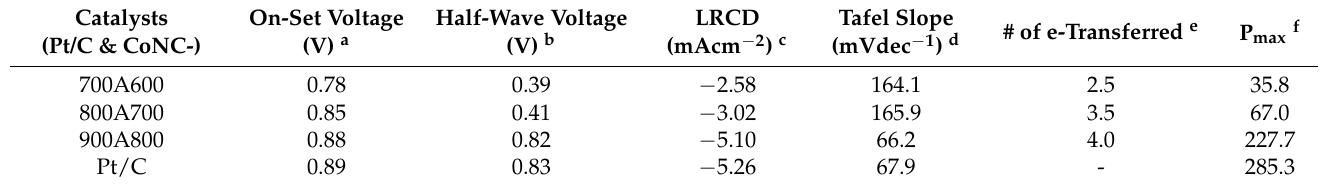
a : obtained from Figure 9b; b : obtained from Figure 9b; c : obtained from Figure 9b; d : obtained from Figure 9c; e : obtained from Figure 9d; f : obtained from Figure 10.